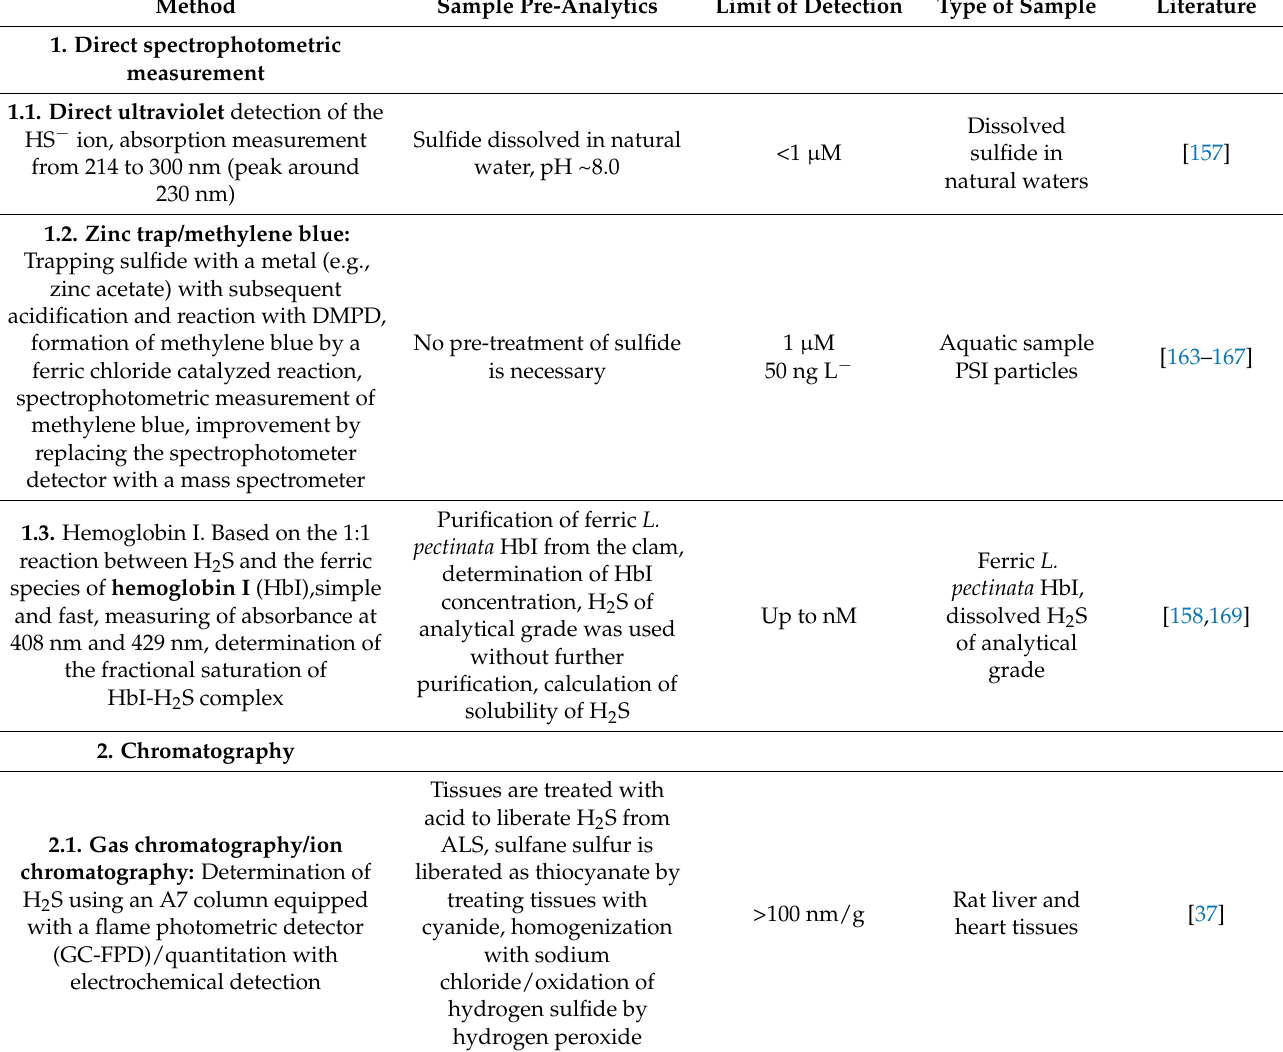
Table 3. Methods of detection of hydrogen